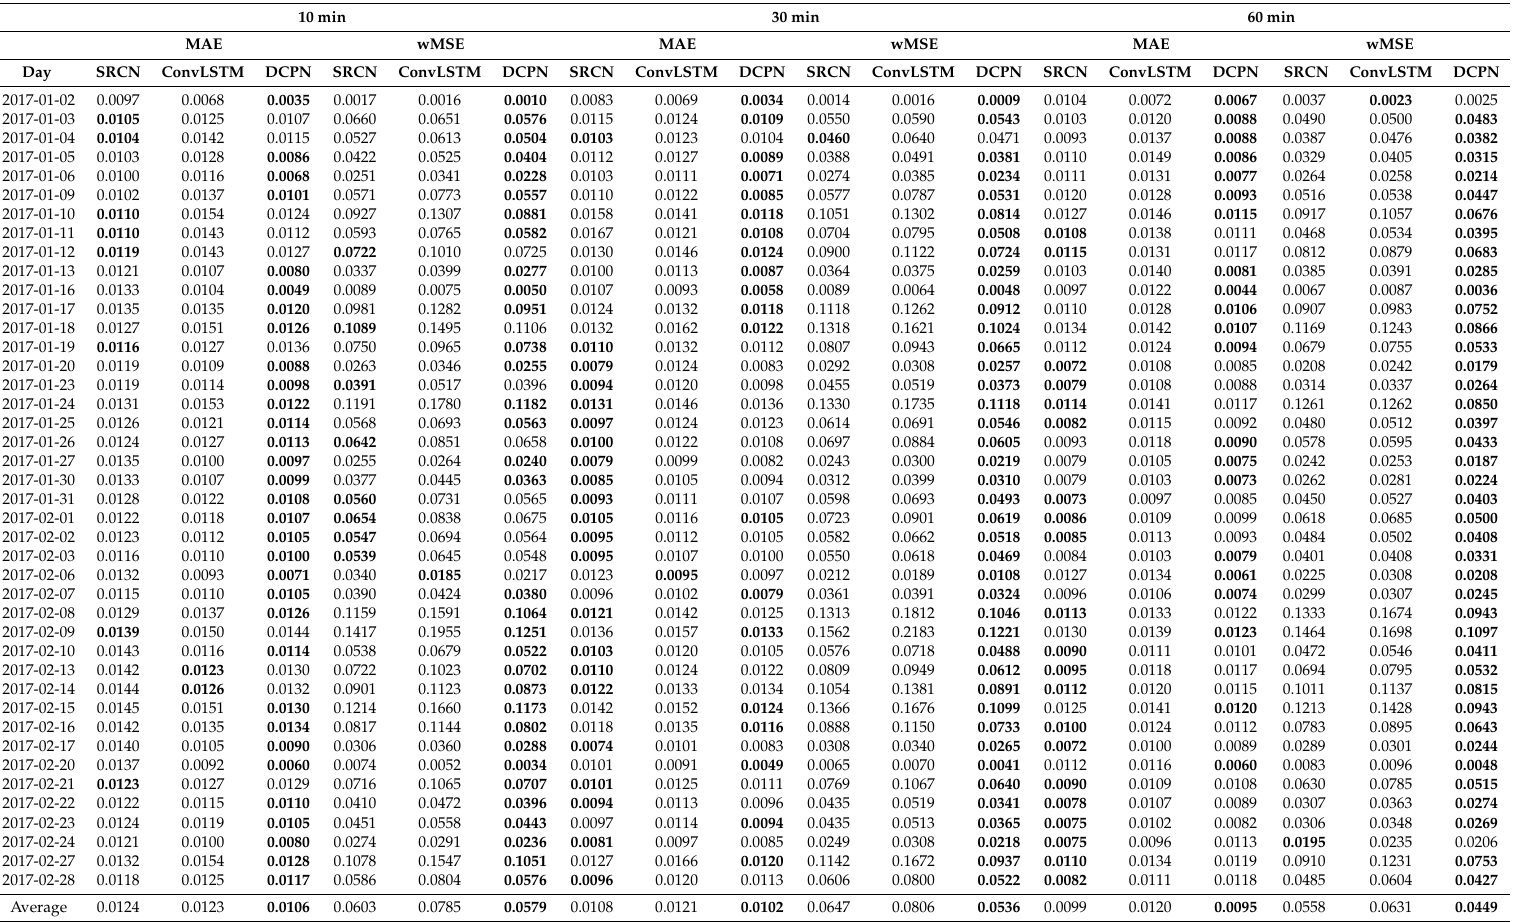
Table 5. MAE and wMSE by day of the whole network at different prediction horizons of 10, 30, and 60 min through back-testing. Best performance values for each day are marked with a bold